Question: How would you classify this visualization?
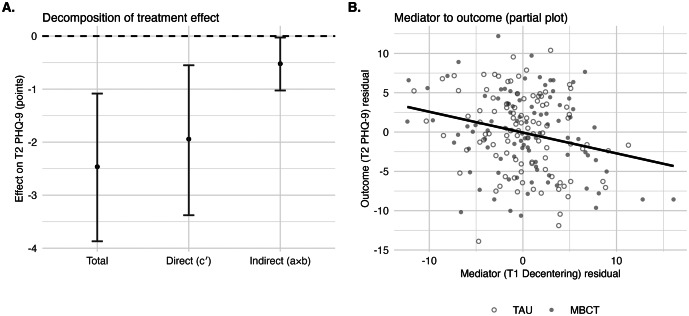
Answer: bar